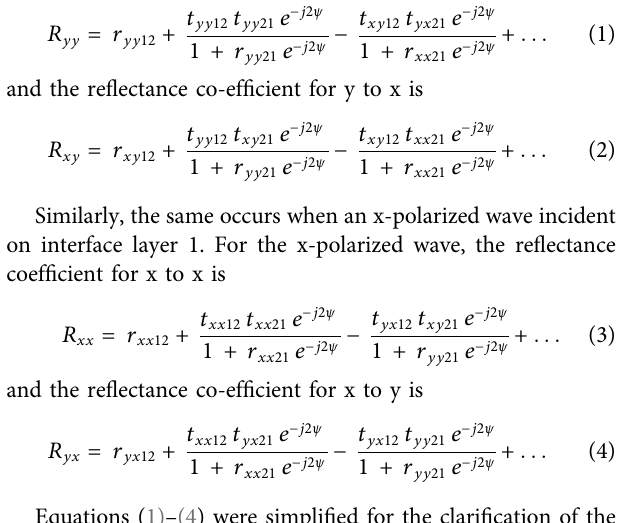
Frontiers in Physics |